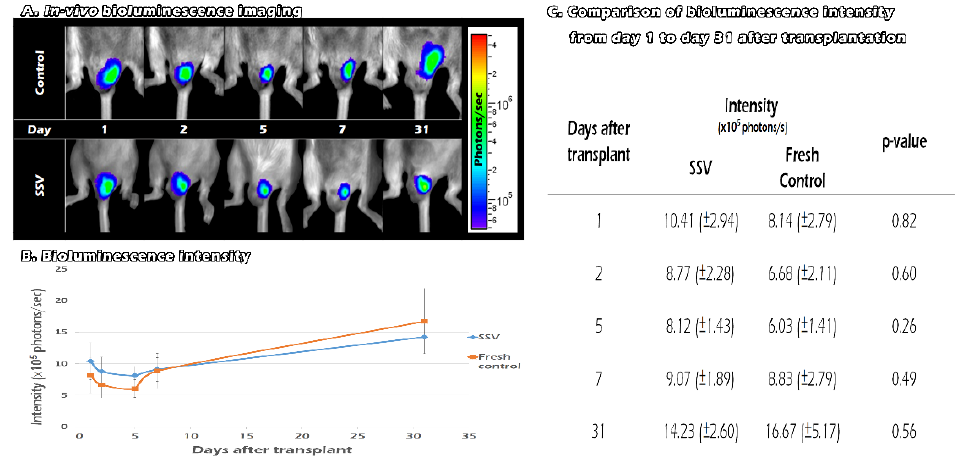
Figure 6. The survival of the graft by in vivo BLI on days 1, 2, 5, 7, and 31 after transplantation ( A ). Compared with day 1, the QYs was significantly stronger at day 31 after transplantation (9.3 × 10 5 photons/s versus 15.4 × 10 5 photons/s). The signals were lower than the control group after day 7 ( B ). There were no significant differences in the QYs between the two groups ( C ).